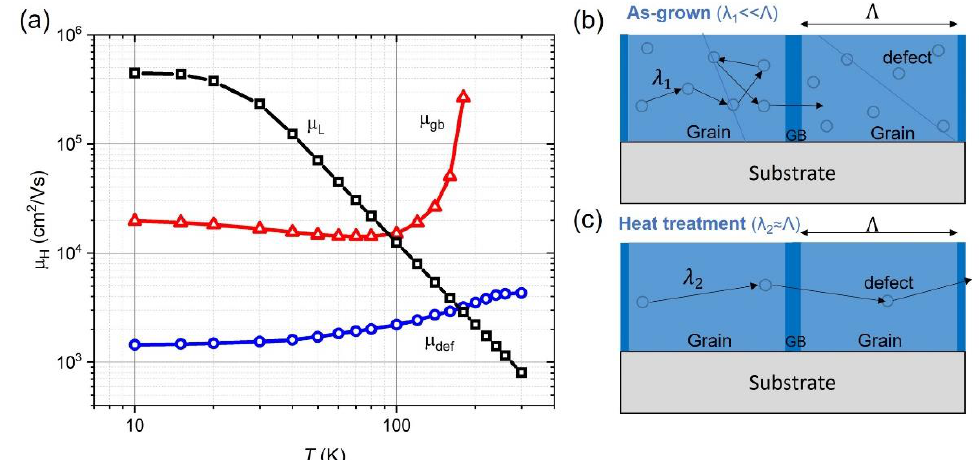
Figure 8. ( a ) Extracted temperature dependence of the electron mobility according to Equation (4). µ L — mobility due to lattice scattering in bulk crystal. µ def — mobility limited by defects, corresponding to the as-grown film . µ gb — mobility limited by grain boundary scattering corresponding to the heat-treated film; ( b , c ) Schematic views of polycrystalline PbTe:In film before and after heat treatment. λ 1,2 — mean free path for as- grown and after heat treatment, respectively, Λ— grain size.